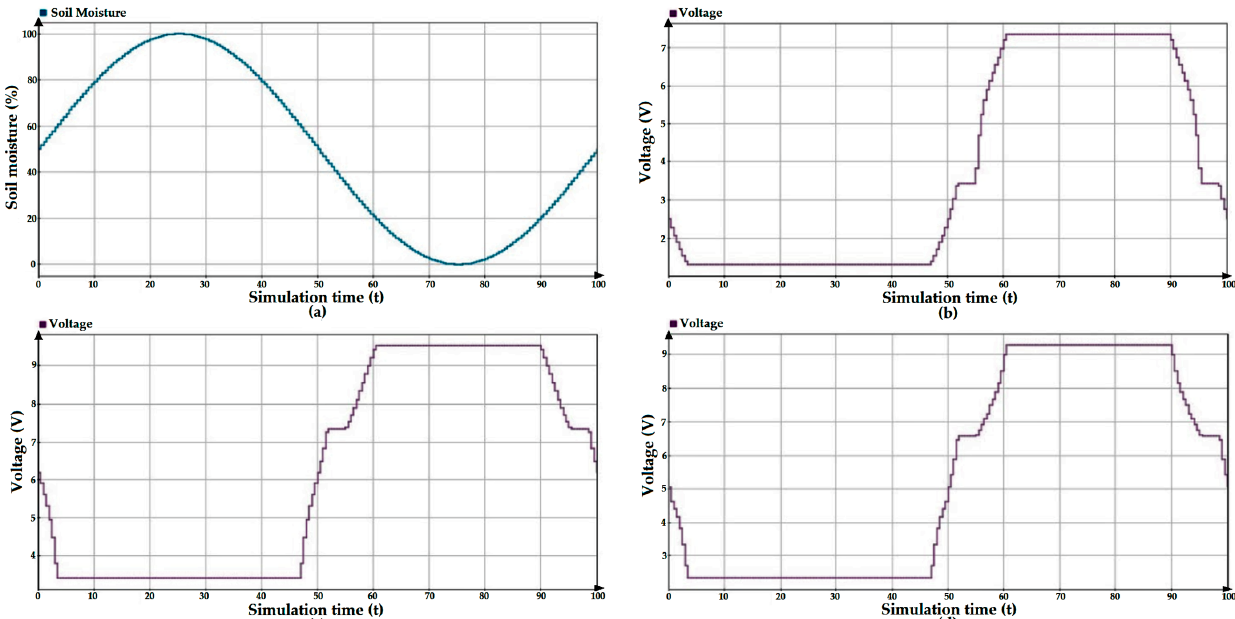
Figure 12. ( a ) Soil moisture vs. time; ( b ) voltage vs. time at minimum water need; ( c ) voltage vs. time at maximum water need; ( d ) voltage vs. time at standard operating